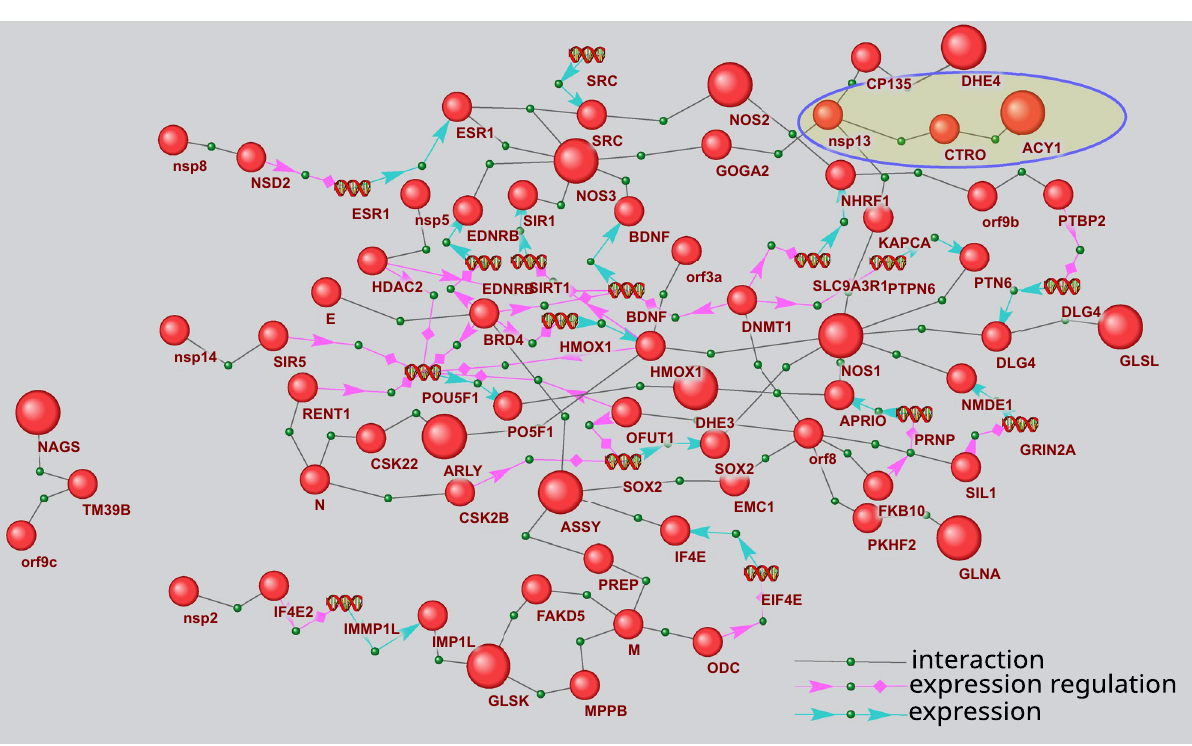
Figure 9. Gene network describing P 2 and P 7 pathways by which the viral proteins can influence the arginine biosynthesis proteins. The bigger balls show the proteins of arginine biosynthesis, while the smaller ones designate other proteins. Spirals designate the genes. The pathways discussed in the text are